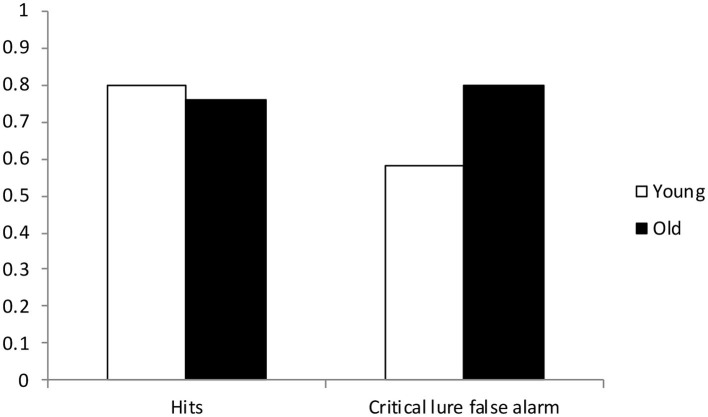
Mean proportion of Hits and Critical lure false alarms as a function of age group (Mage Young = 20.1; Mage Old = 70.7), adapted from Balota et al. (1999).